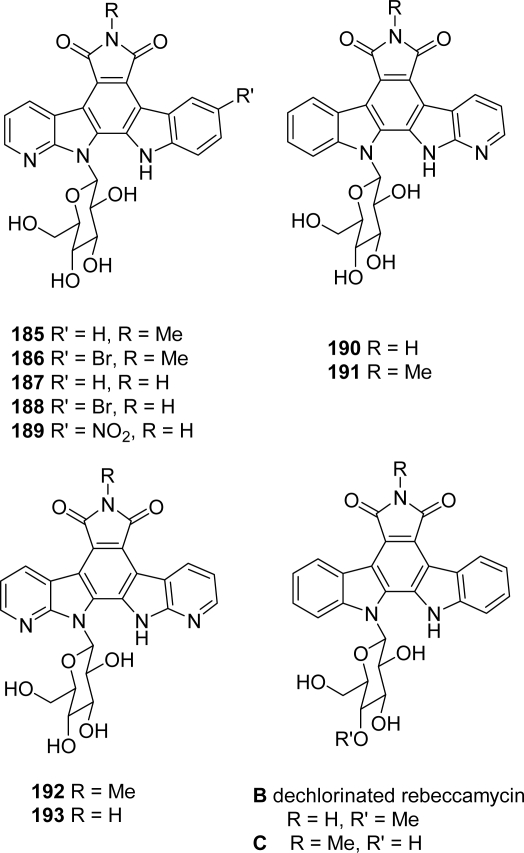
7-Azarebeccamycin analogues bearing one or two azaindole moieties and dechlorinated rebeccamycin analogues B and C.